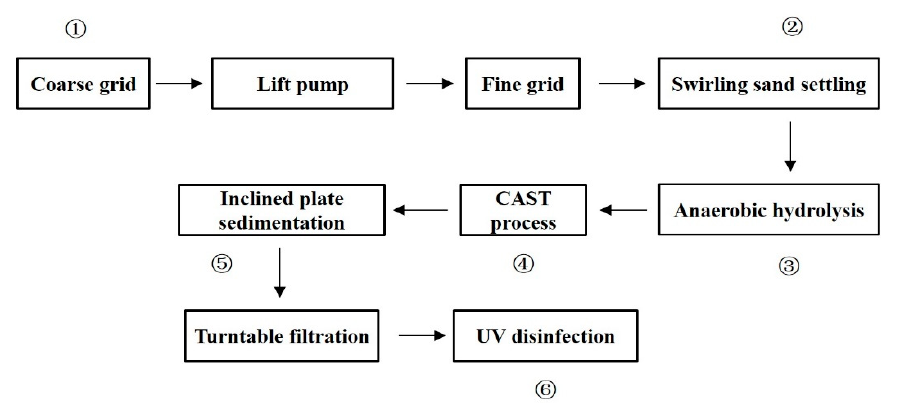
Figure 2. Sampling points in the CAST-process WWTP.